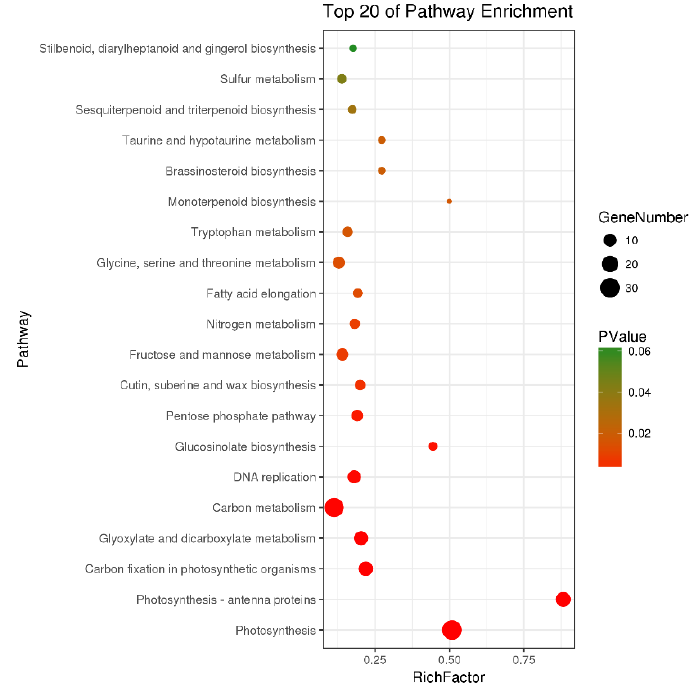
Figure 10. Pathway enrichment bubble map of differentially expressed genes (DEGs).